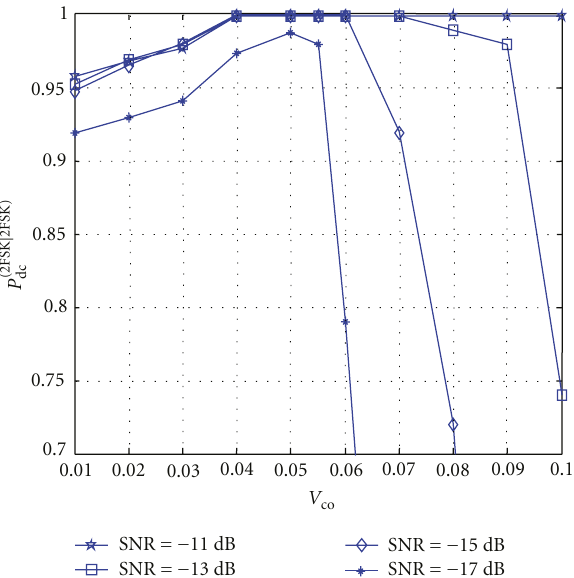
Figure 4: The probability of detection and correct classification, , as a function of the cuto ff value, V co , for several SNR P (2FSK | 2FSK) dc values and 1-second observation